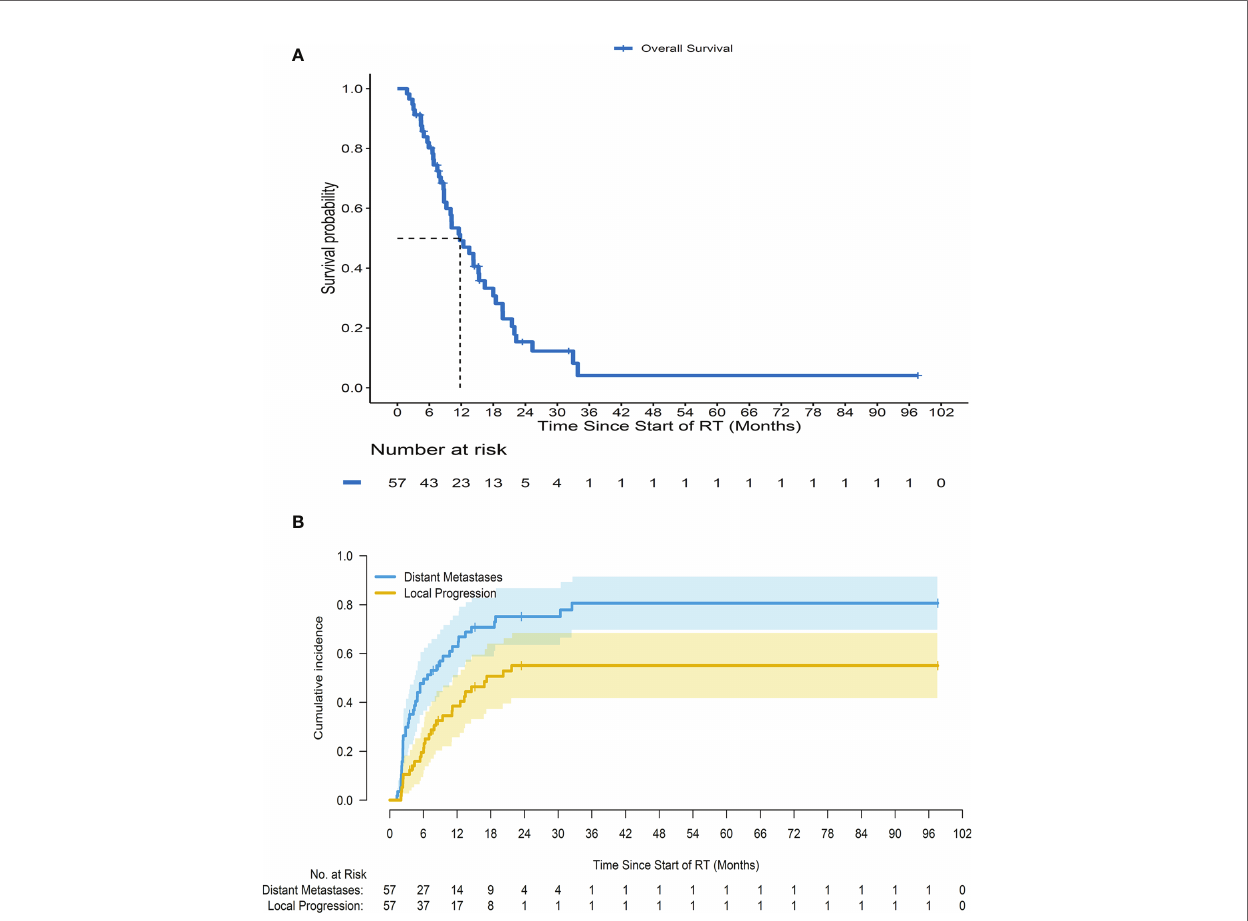
FIGURE 2 | Survival curves for all patients. (A) Overall survival for all patients since starting radiotherapy. (B) Cumulative incidence of local progression and distant metastases for a cohort of patients since starting radiotherapy after adjusting death as a competing